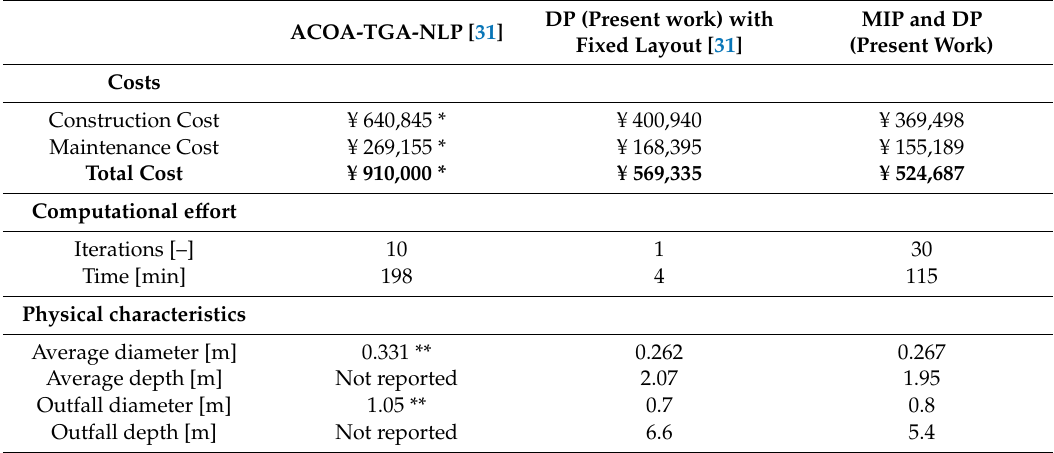
Table 3. Comparison of the total cost for the benchmark proposed by Moeini and Afshar